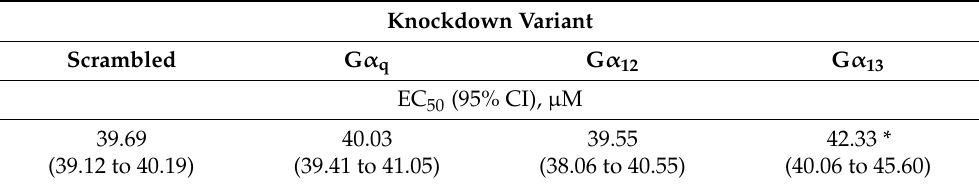
Table 5. Cytotoxicity of DHA-DA for the MDA-MB-231 line with the knockdown of G α subunits. The cells were treated for 72 h after siRNA transfection; incubation with the substance was for 24 h. MTT test